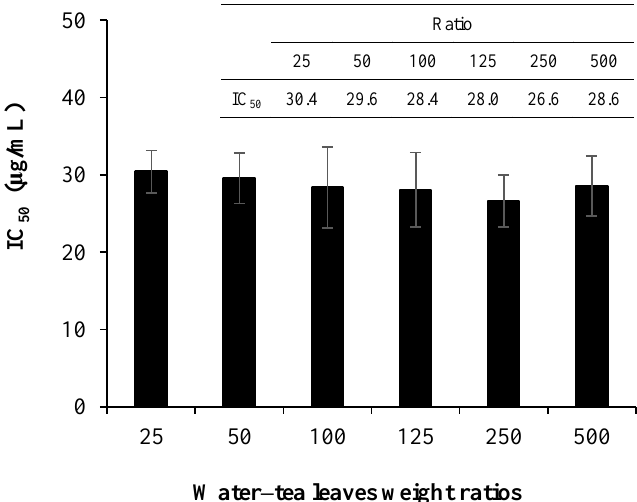
Figure 2. Relationship between 1,1-Diphenyl-2-picrylhydrazyl (DPPH) IC 50 and the water–tea leaves weight ratio.